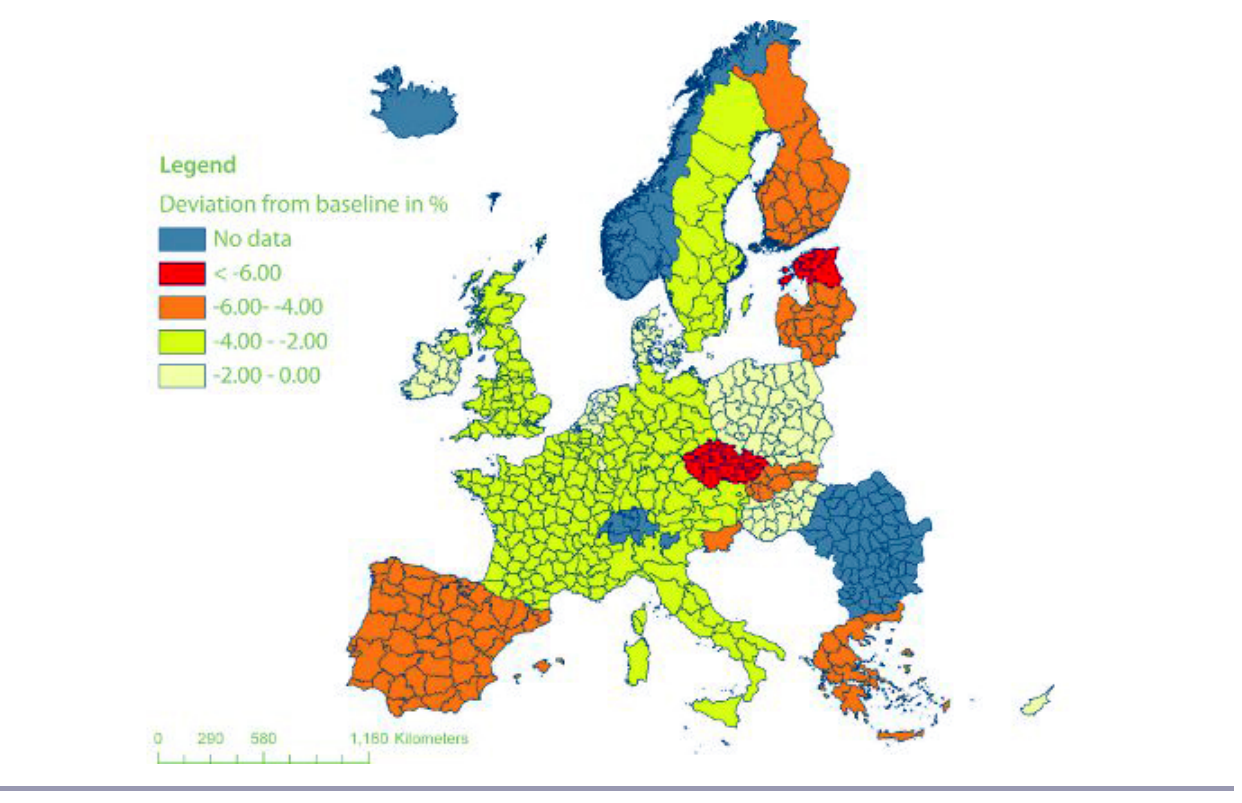
Fig. 6 . Common Agricultural Policy financial reform scenario: 100% cut of Common Agricultural Policy first pillar measures (market support and direct income support), and a re-investment of savings in research and development. The map shows the impacts on the number of employed persons in the agricultural sector in terms of the deviation from the baseline scenario for the year